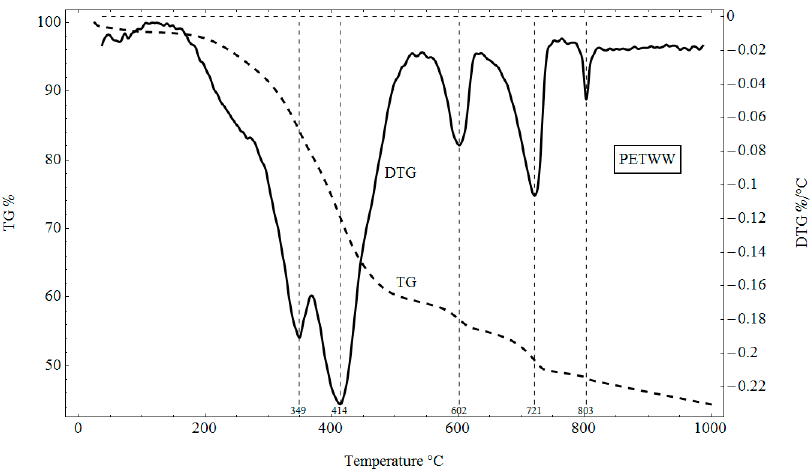
Figure 5. Weight loss curve (TG) and thermogravimetric differential curve (DTG) for the PETWW investigated.